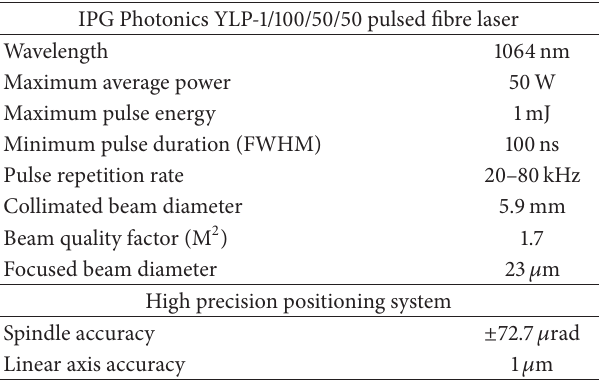
Table 1: General specifications of the laser micromachining system used in the laser microcutting of AZ31 tubes.